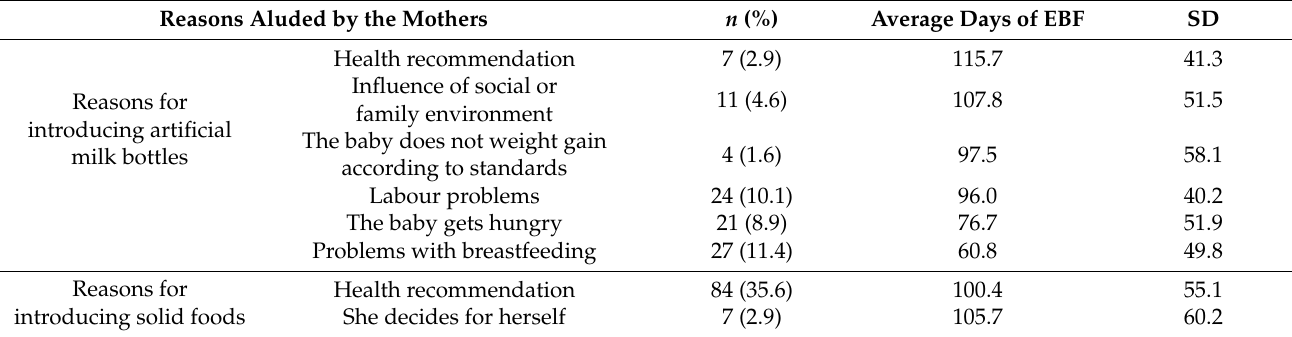
Table 4. Reasons for cessation and duration of exclusive breastfeeding (women who practiced exclusive breastfeeding). Reasons Aluded by the Mothers